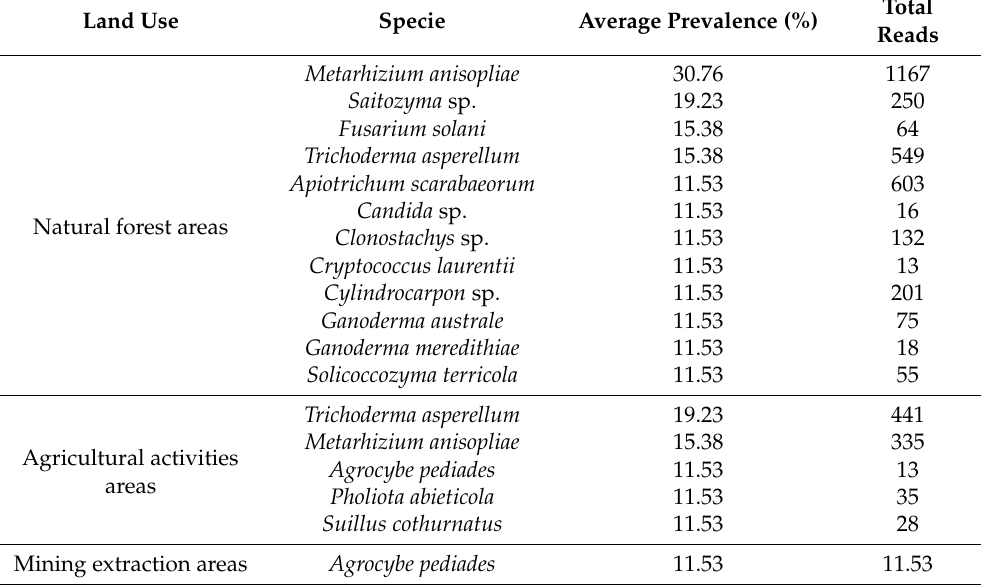
Table 2. Prevalent fungal species identified across different land uses in Colombian